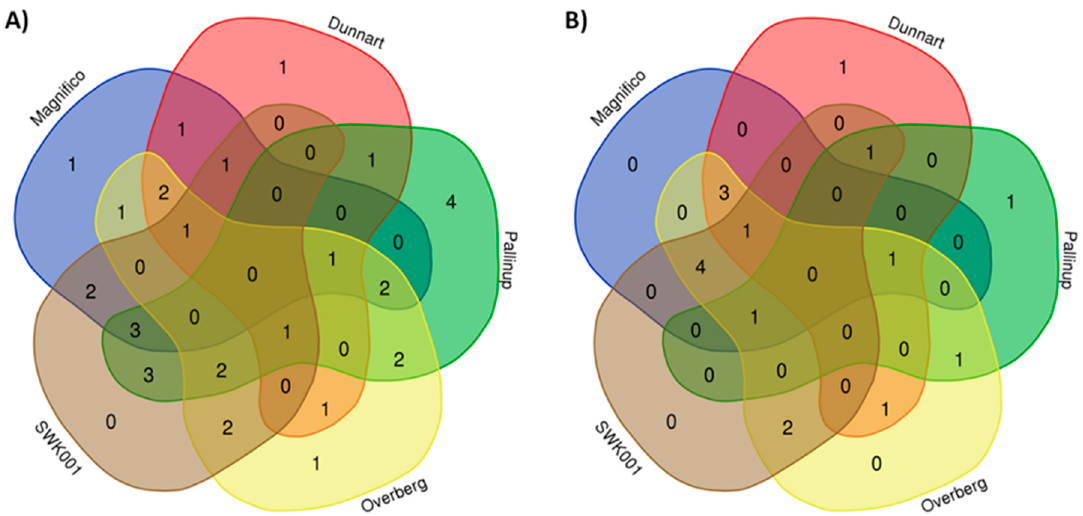
Figure 8. Venn diagrams displaying the partial overlap and differences of statistically significant variables selected from the OPLS-DA models for ( A ) leaves and ( B ) roots. The numerical values in the diagram represent the discriminatory metabolites (Table 1) that are unique to the respective cultivars and, conversely, also shared between the cultivars.